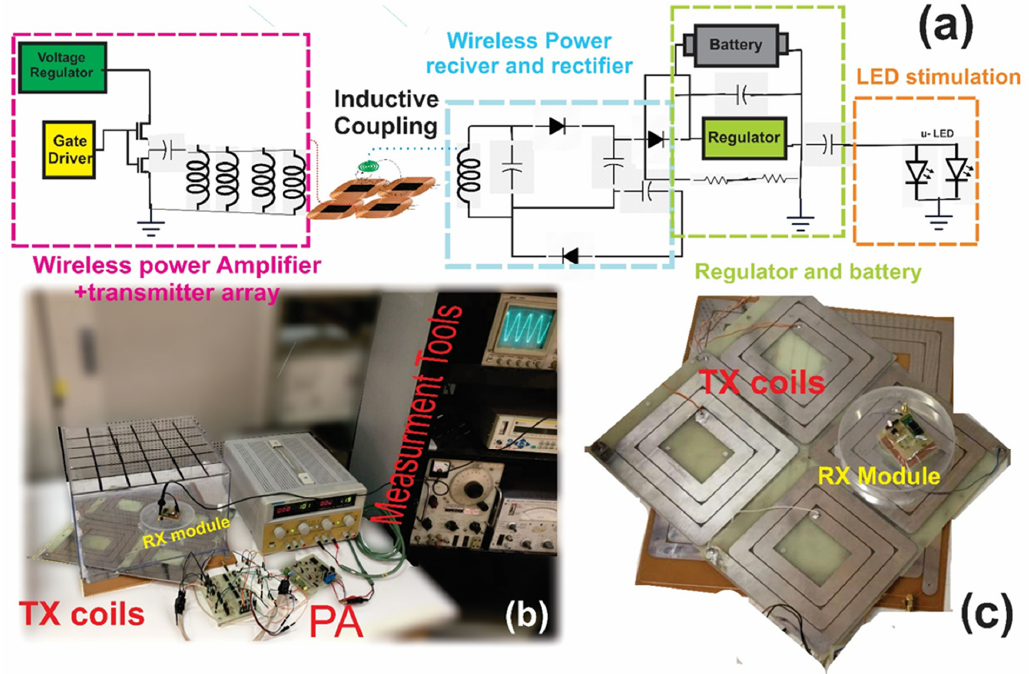
Figure 7. Schematic and Measurement setup of proposed WPT configuration. ( a ) Schematic block diagram of the measurement setup. ( b ) Measurement set up and test setup using array and the RX module and measurement equipment and ( c ) fabricated star shaped coils and RX module. Table 1. Specification of the fabricated coils.